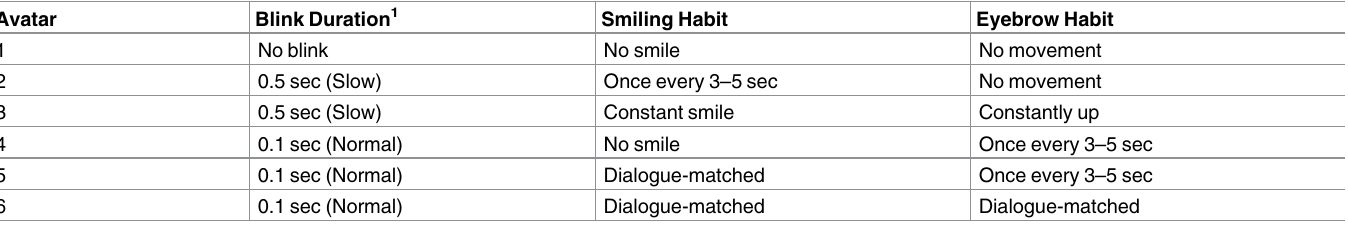
Table 1. AvatarFacial